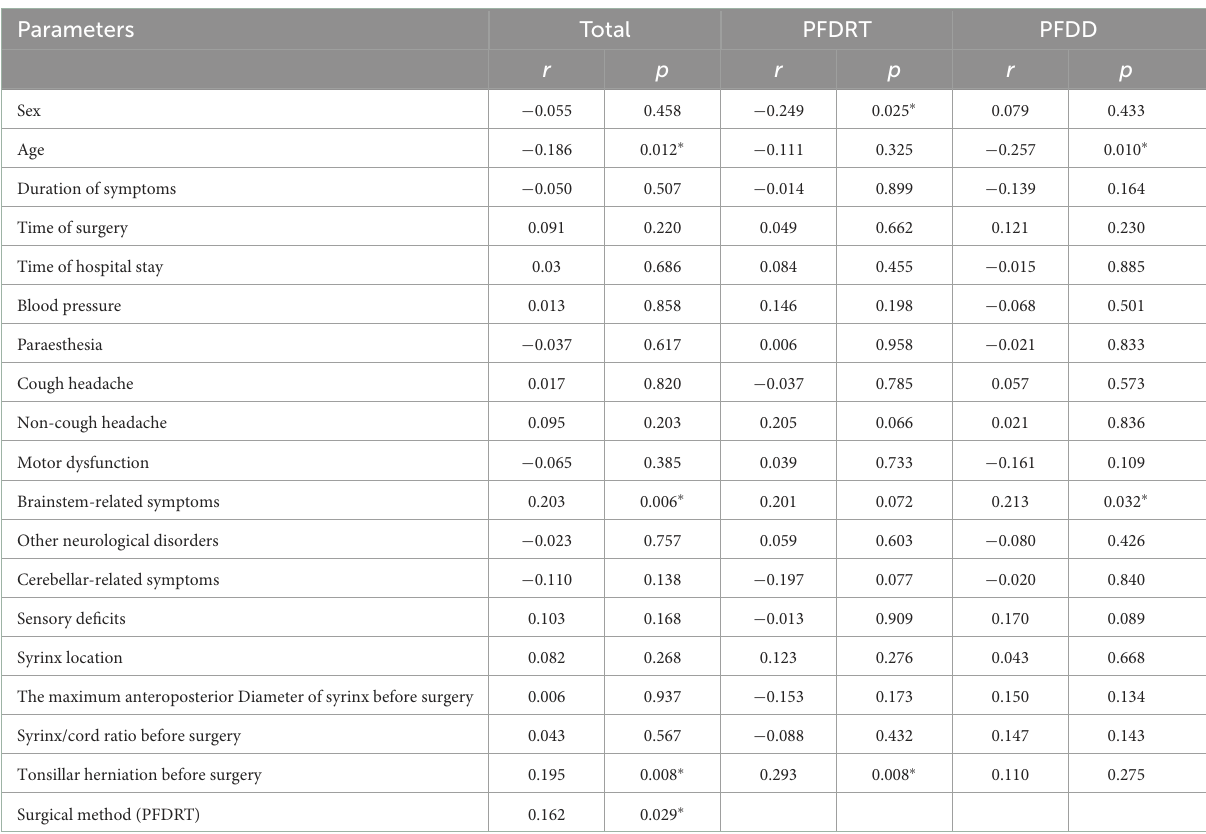
TABLE 5 Syrinx remission rate bivariate correlation